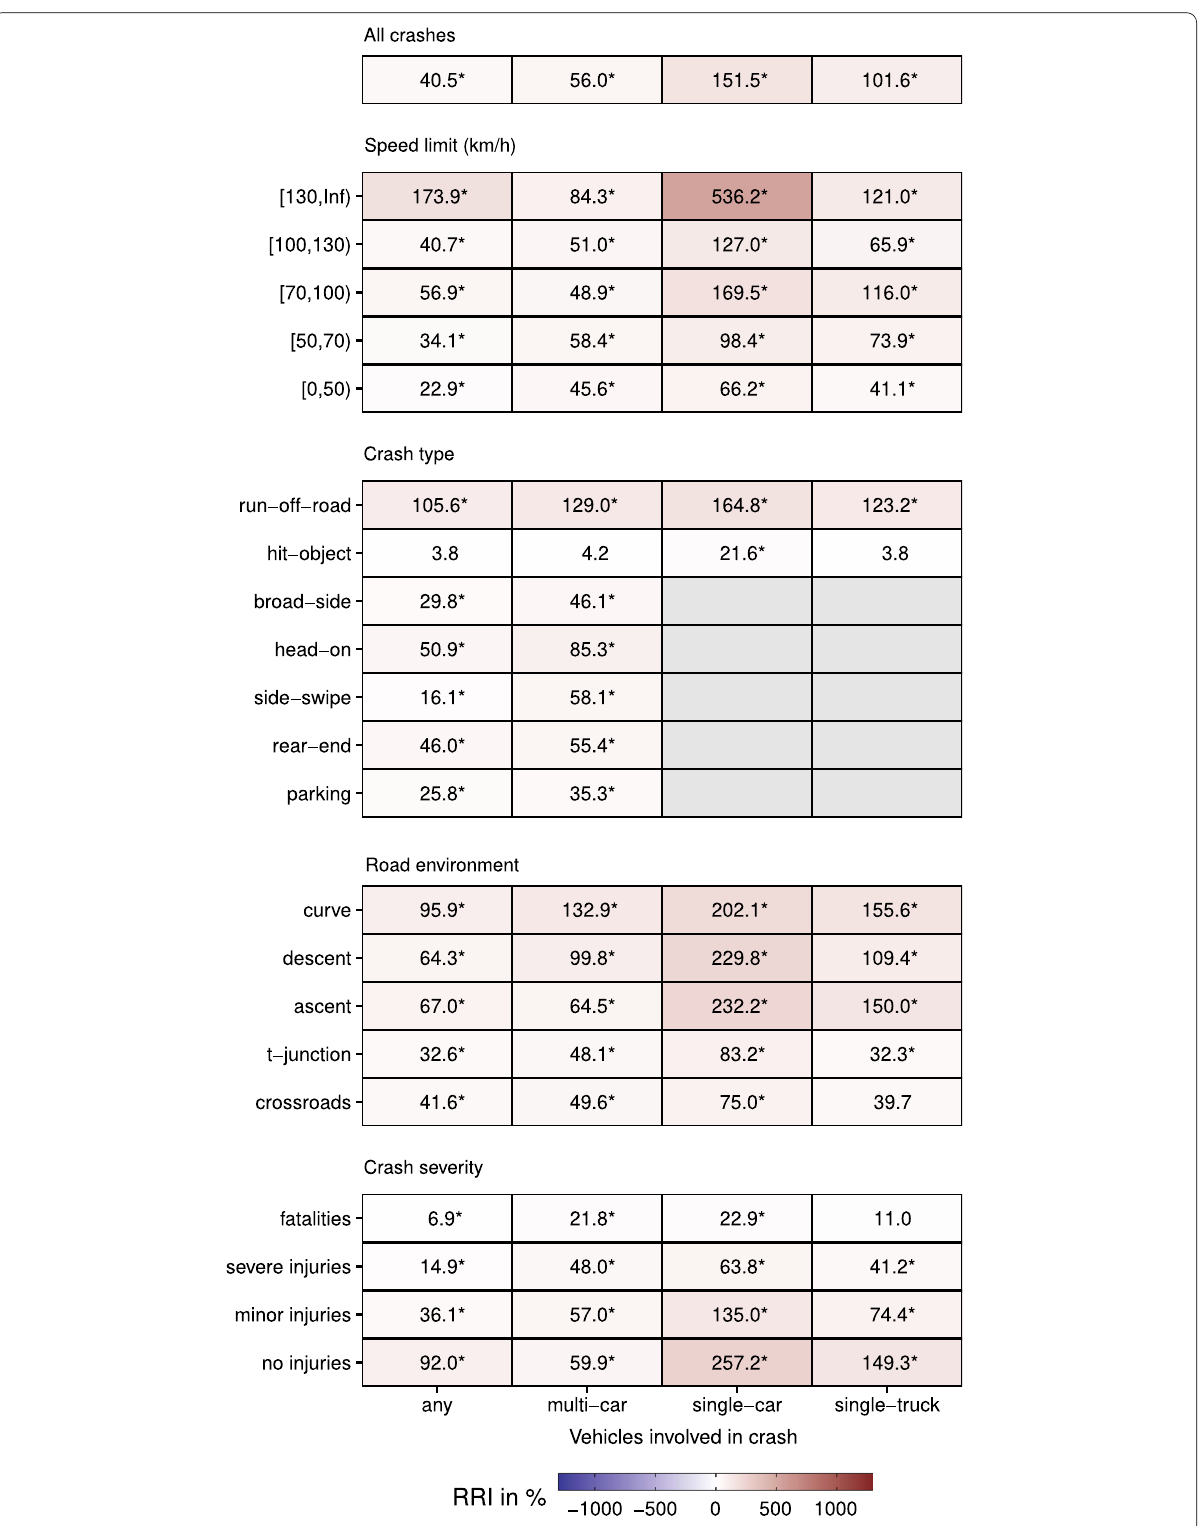
Fig. 4 Relative risk increase (RRI) of crash probabilities in situations with precipitation and positive temperature ( Tmp = 15 ◦ C and Prc = 1 mm/h) compared to situations without precipitation and positive temperatures ( Tmp = 15 ◦ C and Prc = 0 mm/h). Significant changes (i. e. more than 95 of 100 models fitted with randomly drawn training data show the same direction of change) are indicated with an